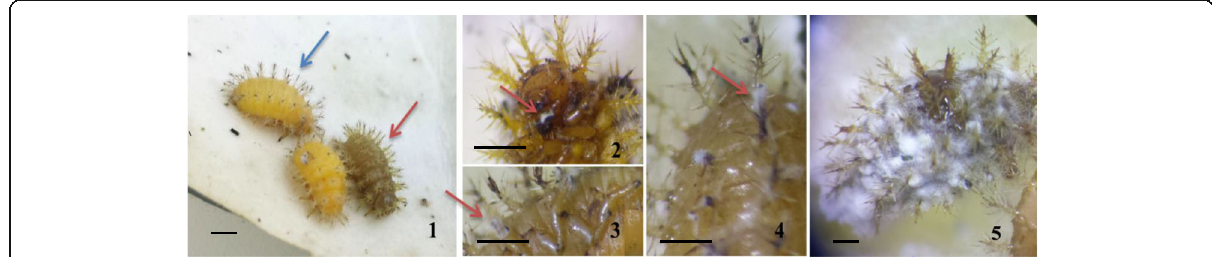
Fig. 3 Epilachna chrysomelina fourth instar larvae infected with Beauveria bassiana . 1 — (Red arrow) Infected larva (color changed to brown) and (blue arrow) healthy larva (shiny yellow) scale bar = 2 mm. 2 — Mycelium emerged from mouth parts. 3 — Mycelium emerged from leg